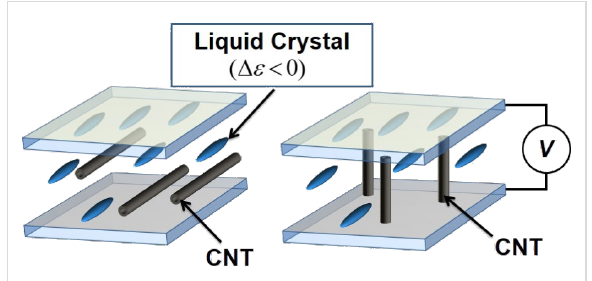
Figure 1: SWCNT-doped negative LC reorientation hypothesis: the LC remains homogeneously aligned while SWCNTs reorient with the applied electric field.